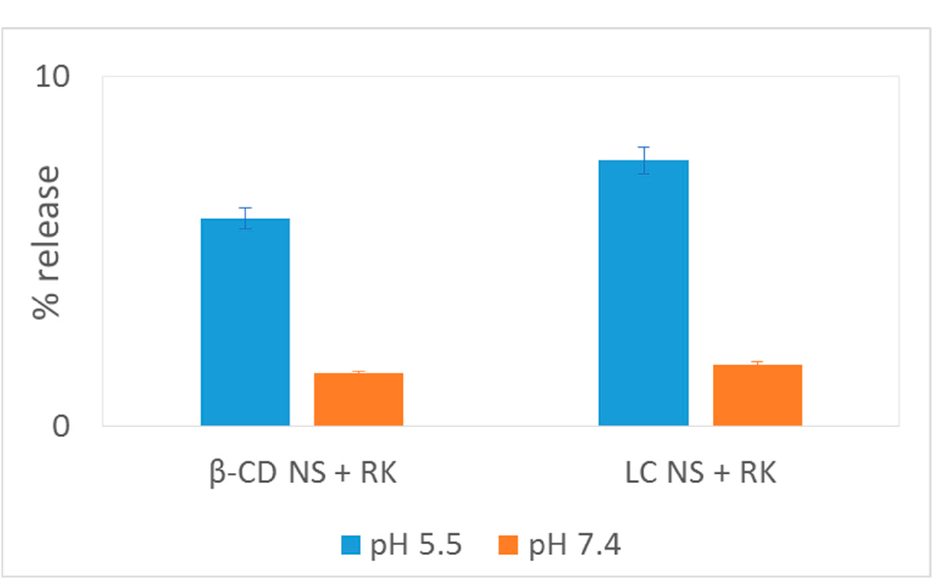
Figure 9. Release of RK-loaded NSs in pH 5.5–7.4 after 28 h.